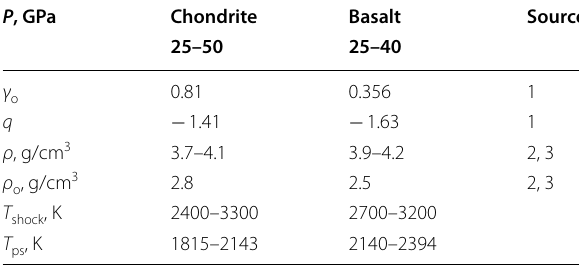
Table 2 Parameters and temperatures of shock